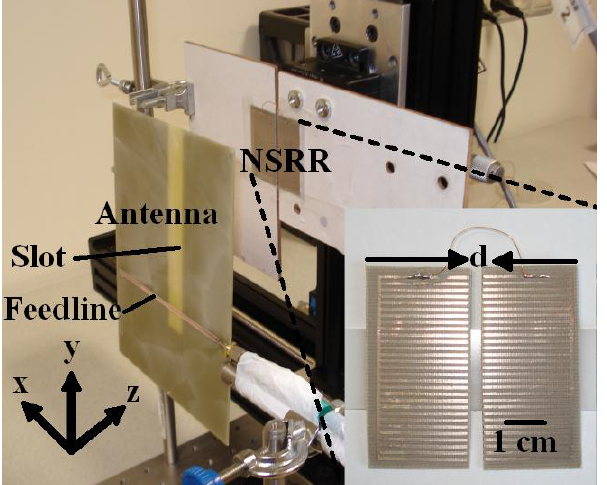
Figure 1. Comb-like NSRR probe and external antenna shown on the test setup, with the comb-like NSRR zoomed in the bottom right corner